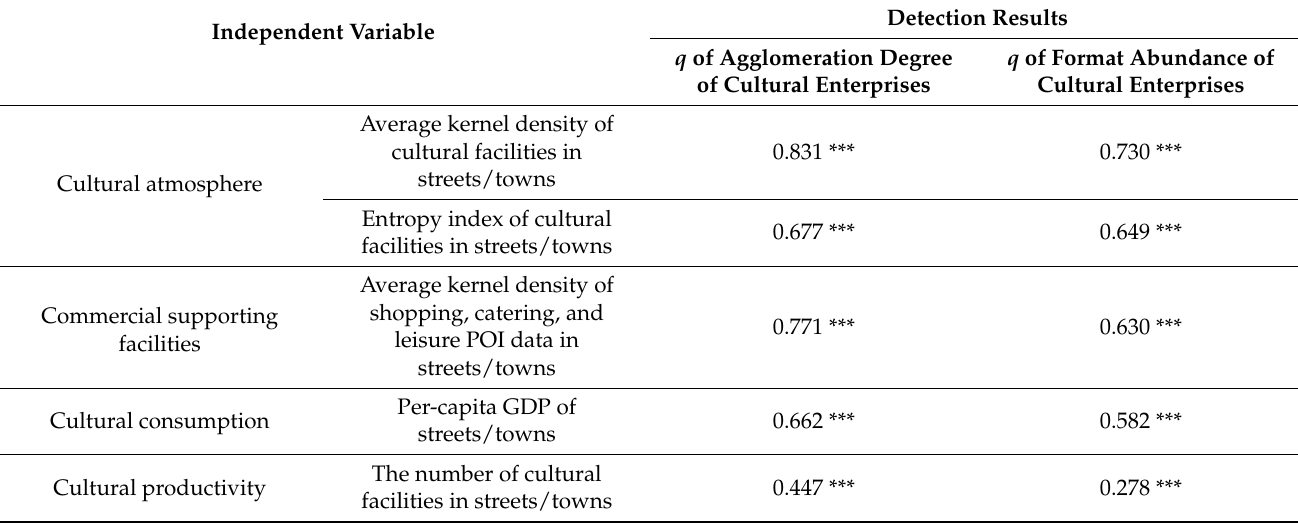
Table 5. Factor detection for the cultural facilities promoting the development of cultural